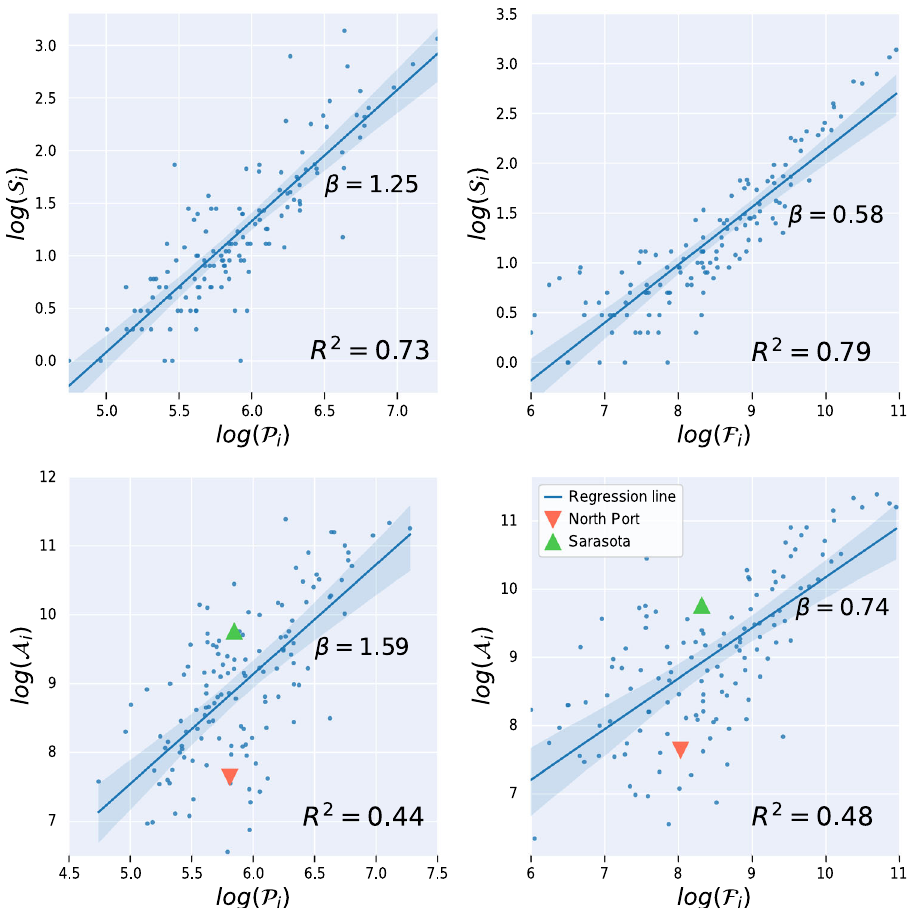
Fig. 3 Scatter plots of our two innovation measures, namely the total number of successful startups S i and the cumulative acquisition price A i , against population size P i and total past fundings F i . Double logarithmic plots, coef fi cients of determination R 2 , and corresponding β -coef fi cients for the four least-square linear regressions are shown.